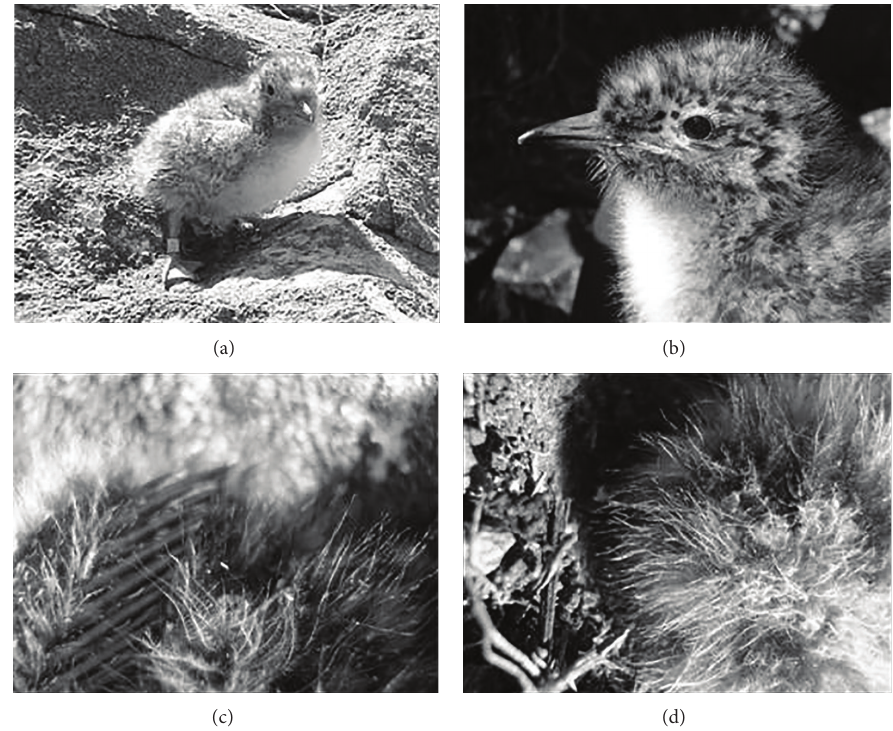
Figure 4: JII of Sterna hirundinacea (a), details of the beak without the egg tooth (b), details of the remiges (c), and rectrices